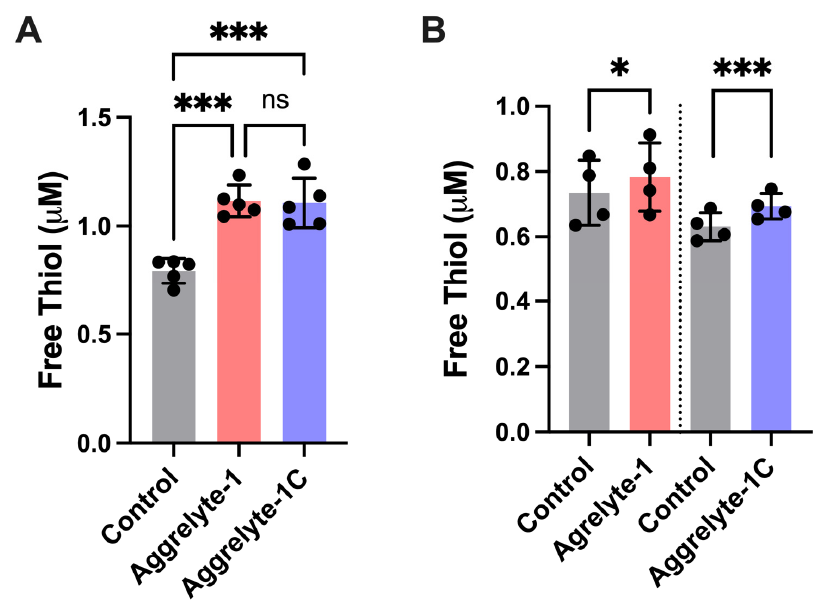
Figure 7. Aggrelytes reduced disulfides in human and mouse lenses. The protein–thiol content in WS (10 µ g) of mouse ( A ) and human lenses ( B ) after treatment with aggrelytes (2000 µ M, 24 h for mouse and 72 h for human lenses) was measured using the Thiol Quantification Assay Kit as described in the Methods section. * p < 0.05, *** p < 0.001, ns = not significant.